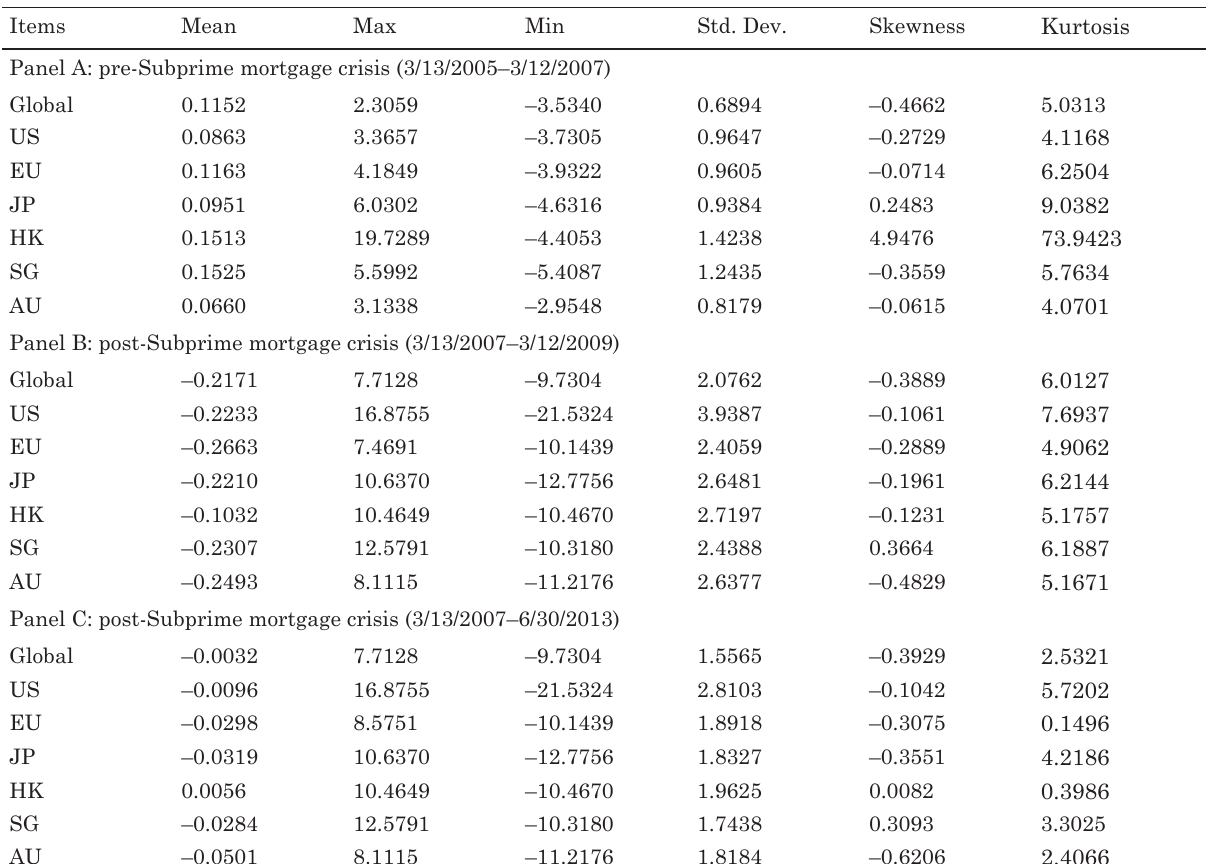
Table 2. Descriptive statistics of the REIT returns